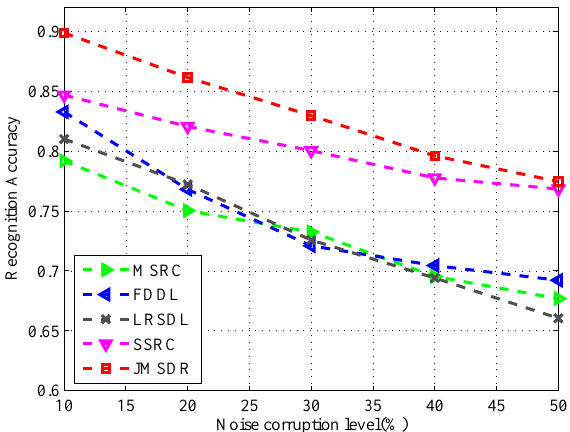
Figure 10. The recognition results of different methods at different level of noise